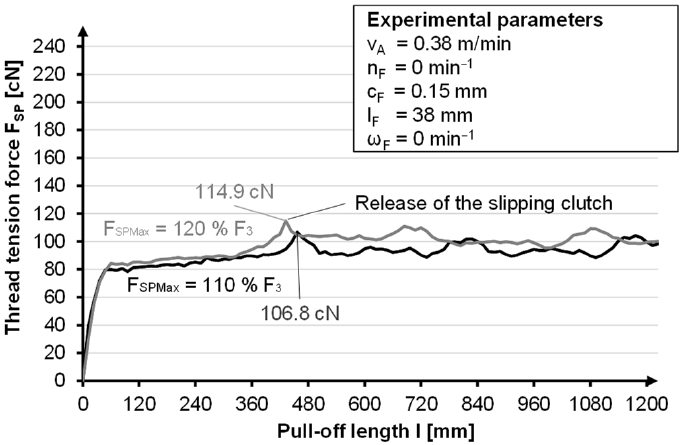
Figure 7. Representation of the yarn tension force as a function of the slipping clutch.